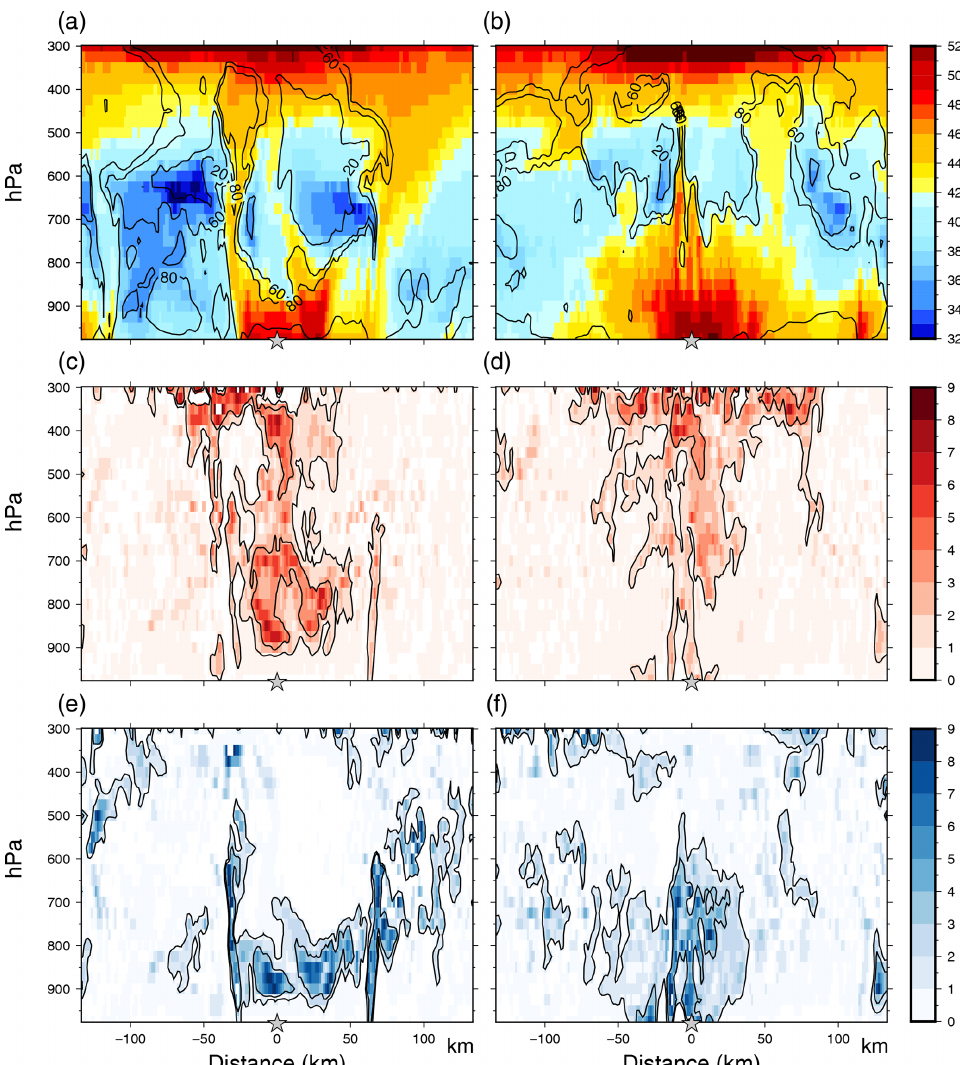
Figure 15. Vertical cross sections of equivalent potential temperature θ e ( ◦ C; colour scale) and relative humidity (%; isolines) (a, b) , DPV (intensity) (c, d) , and WPV (intensity) (e, f) on a west–east transect across the cyclone centre, at 13:00 (a, c, e) and 18:00UTC (b, d, f) on 7 November, in the CPL simulation. The black contours in (c) to (f) correspond to intensities 1 and 3 (as defined in Miglietta et al.,